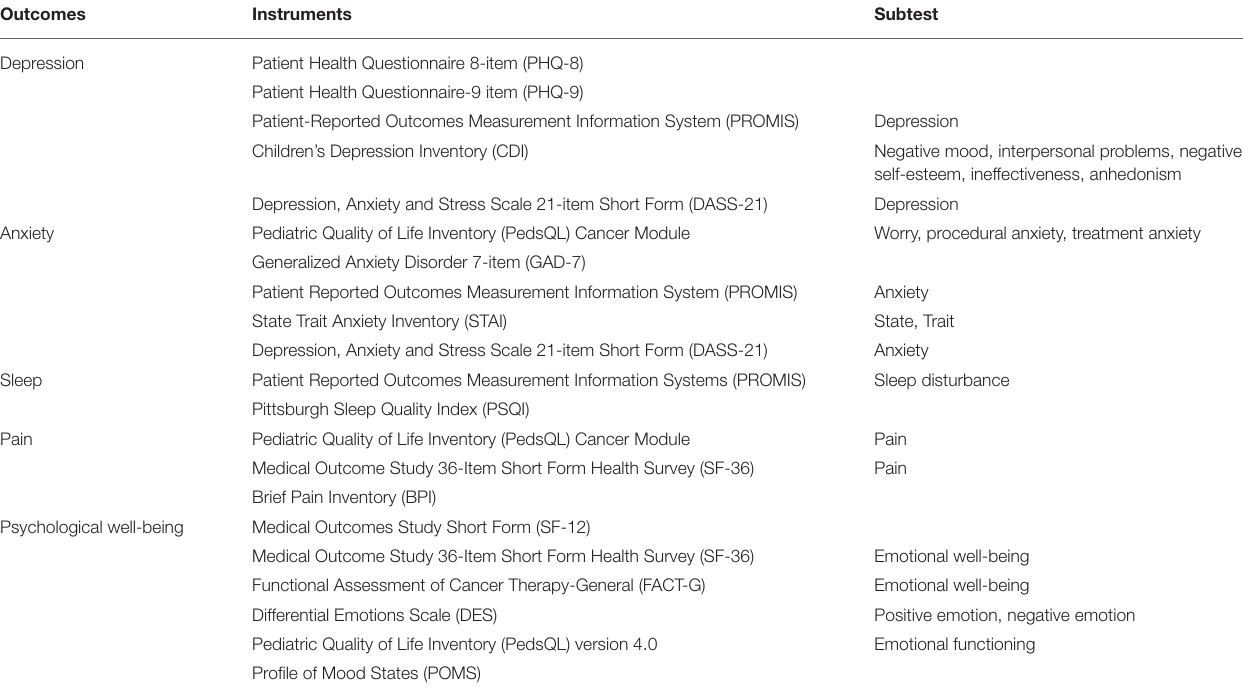
TABLE 2 | Instruments for